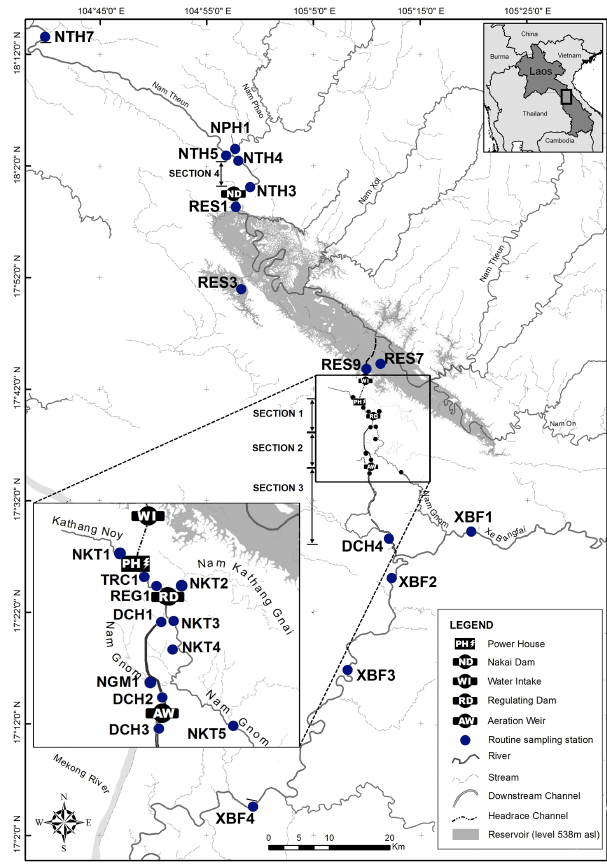
Figure 1. Map of the Nam Theun 2 Hydroelectric Reservoir (Lao People’s Democratic